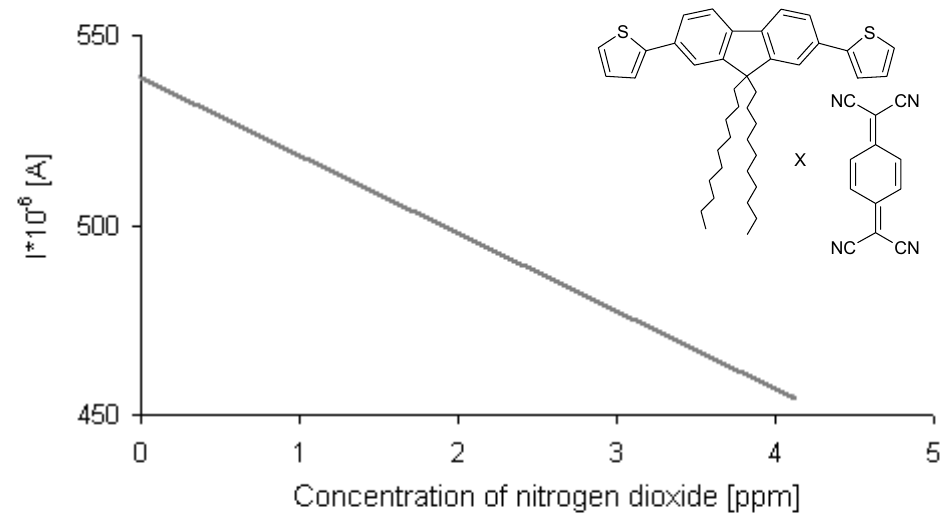
Figure 9. Conductivity response of a five layer LB film to increasing NO in the atmosphere surrounding the sample; U = 15 mV